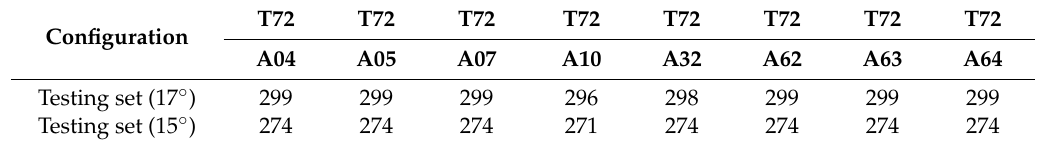
Table 8. The dataset descriptions of the eight T72 configurations.